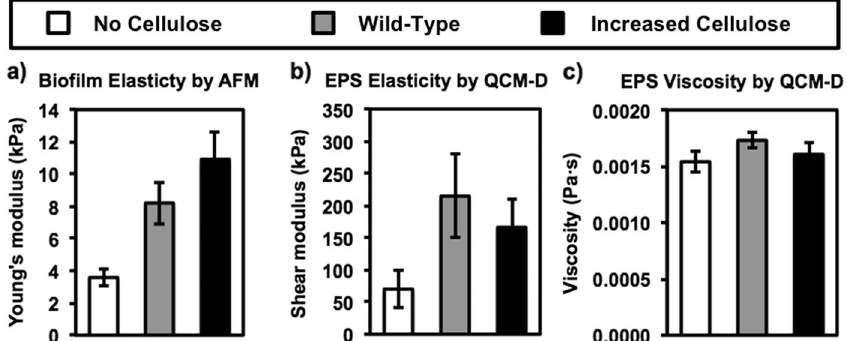
Fig. 6 Bio fi lm elasticity measured by AFM ( a ), and EPS shear modulus ( b ) and shear viscosity ( c ) measured by QCM-D for no cellulose, wild-type, and increased cellulose V. fi scheri strains. Error bars represent 1 standard error